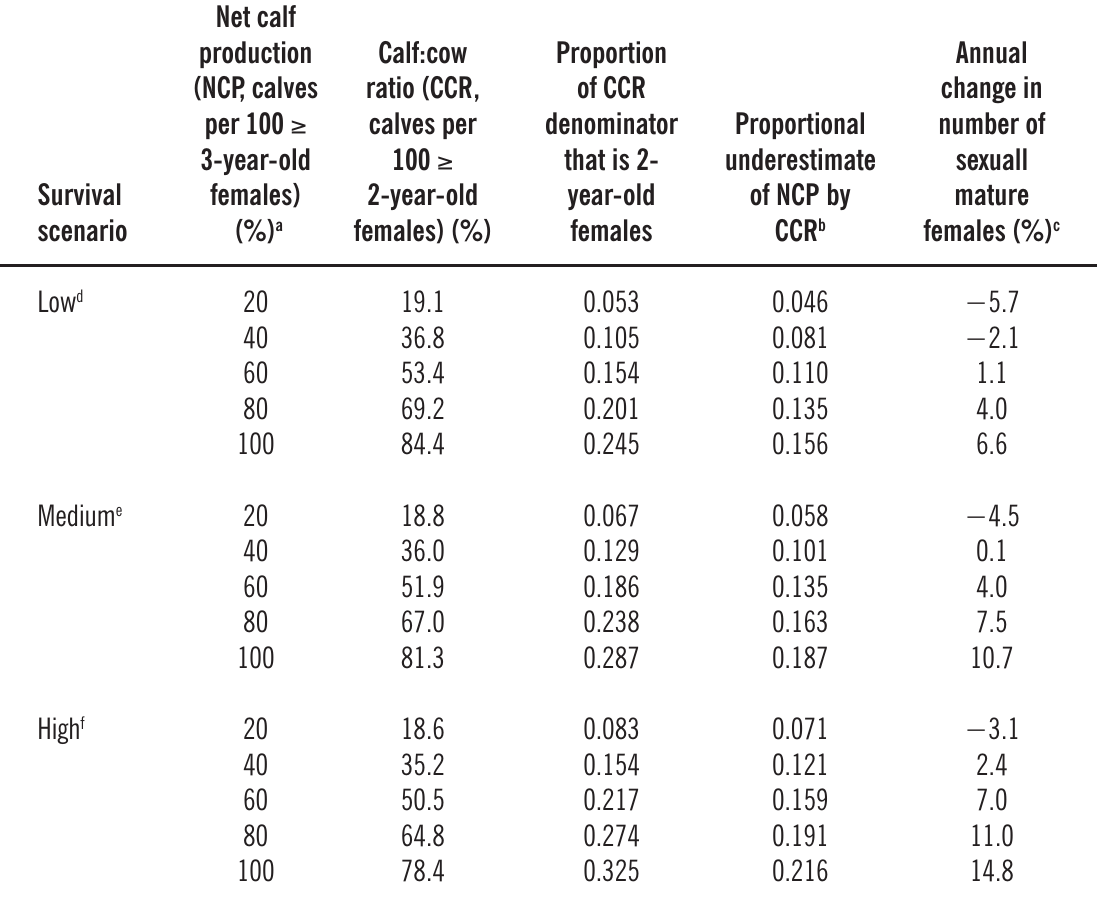
Table 1. Underestimates of net calf production (NCP) by calf:cow ratios (CCR) and chang- es in the number of sexually-mature females derived from 10-year